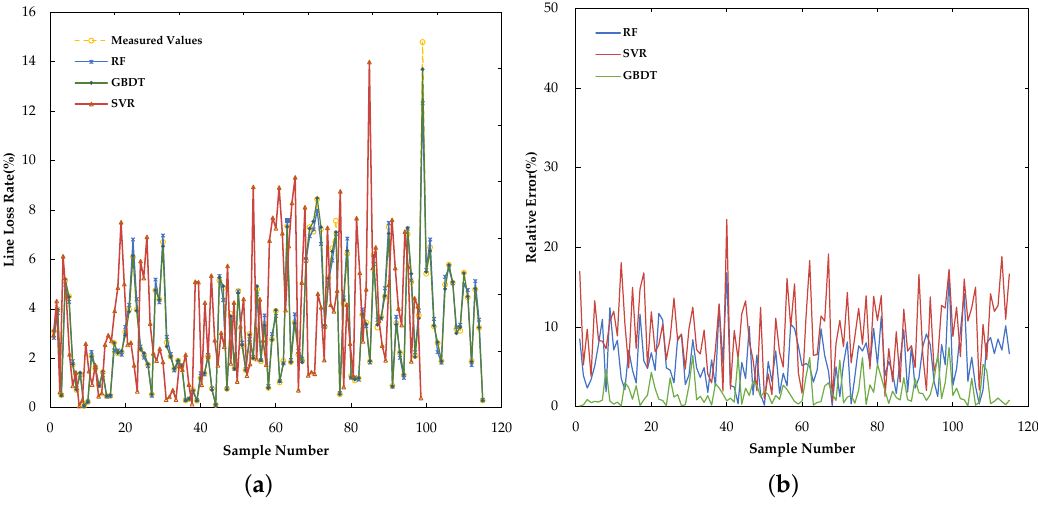
Figure 8. Prediction and error curve of three models. ( a ) Prediction curve for three models, and ( b ) relative error curve for three